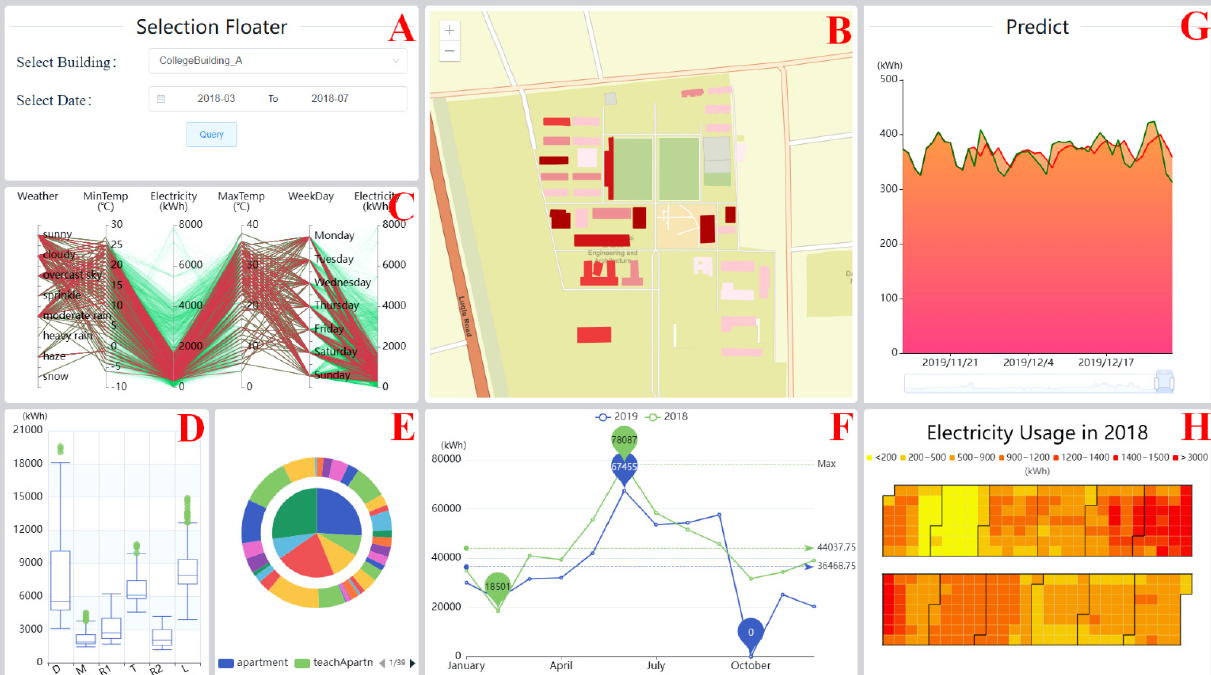
Figure 7. The SmartEle system. ( A ) denotes the selection panel. ( B ) denotes the heat map view. ( C ) denotes the electricity consumption related factors view. ( D ) denotes the anomaly monitoring view. ( E ) denotes the electricity consumption percentage view. ( F ) denotes the electricity consumption trend view. ( G ) denotes the electricity consumption predict view. ( H ) denotes the electricity consumption calendar view. In ( C ), D denotes the dormitory community, M denotes the master and doctoral apartment community, R1 denotes the research community, T denotes the teaching com- munity, R2 denotes the recreation community and L denotes the logistics community.